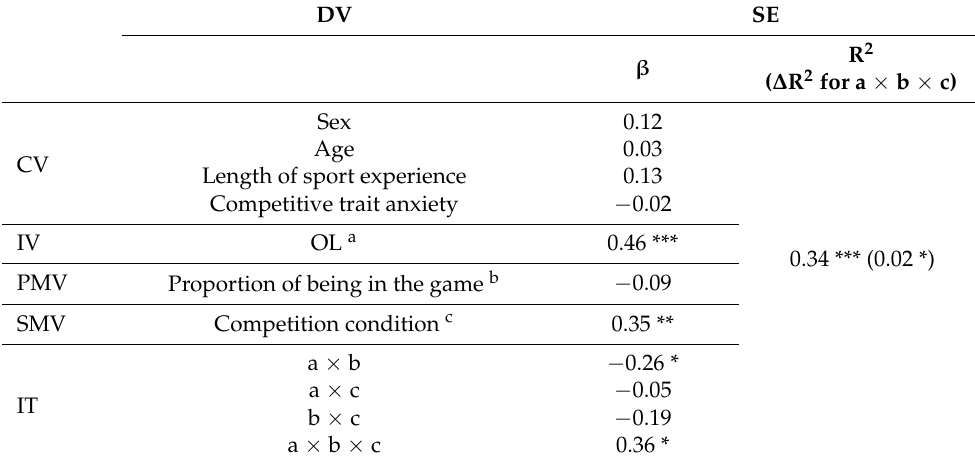
Table 3. The Moderated Mediation